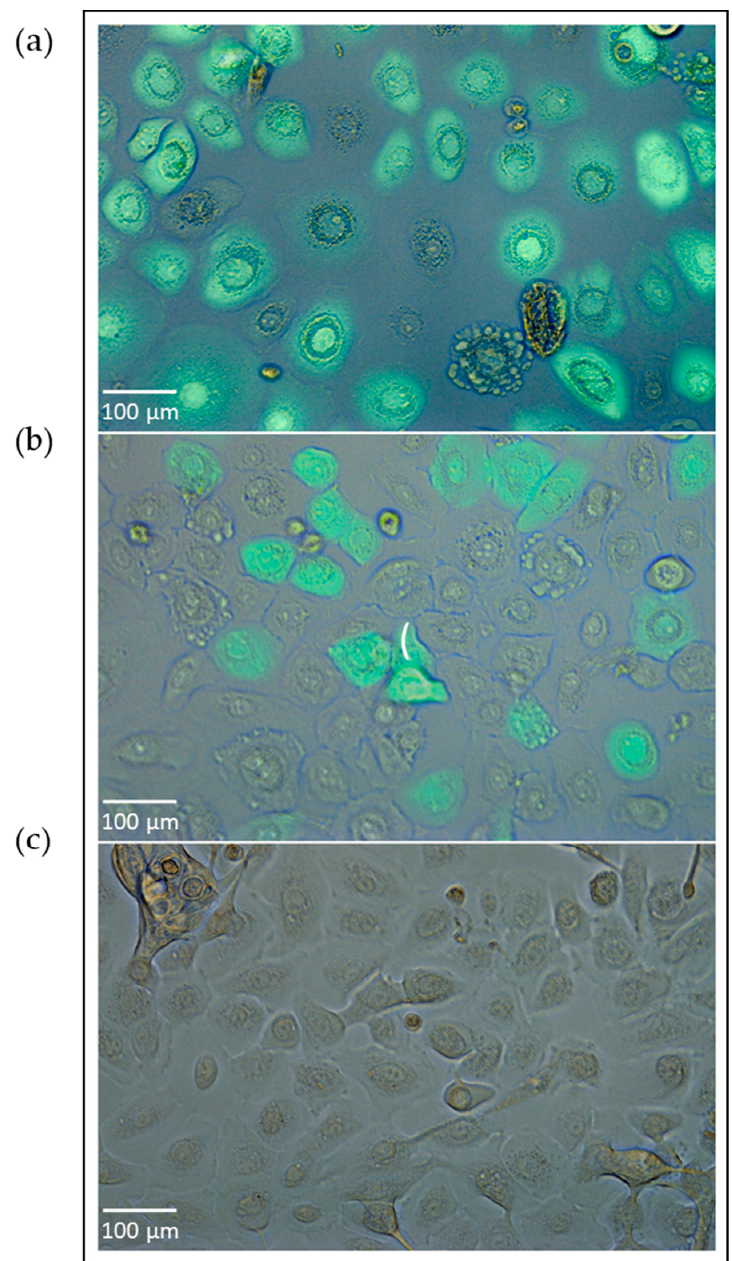
Figure 1. The submerged culture of nasal epithelial cells transduced with adenovirus. The cultivation of nasal epithelial cells derived from a healthy subject from our pediatric exacerbation study cohort [96]. Nasal epithelial cells were seeded in an amount of 20,000 cells per well and resuspended in BEGM TM medium (Lonza, Basel, Switzerland) in collagen-coated 24-well culture plates prior to virus transduction. The next day, previously established recombinant adenovirus type 5 encoding green fluorescent protein [97] was added in different virus particle concentrations (vpc) (e.g., 1 × 10 8 vpc), incubated for one day upon viral transduction, and the transduction efficiency was analyzed through immunofluorescence microscopy. The subfigures ( a ) ( b ) represent virus transduction efficiencies in nasal epithelial cells directly correlating with virus transduction rates. The picture ( c ) shows the nasal epithelial cells without viral transduction (untreated, wildtype cells). This experiment was separately performed for this manuscript, correlates thematically with [22], and was not previously published elsewhere.